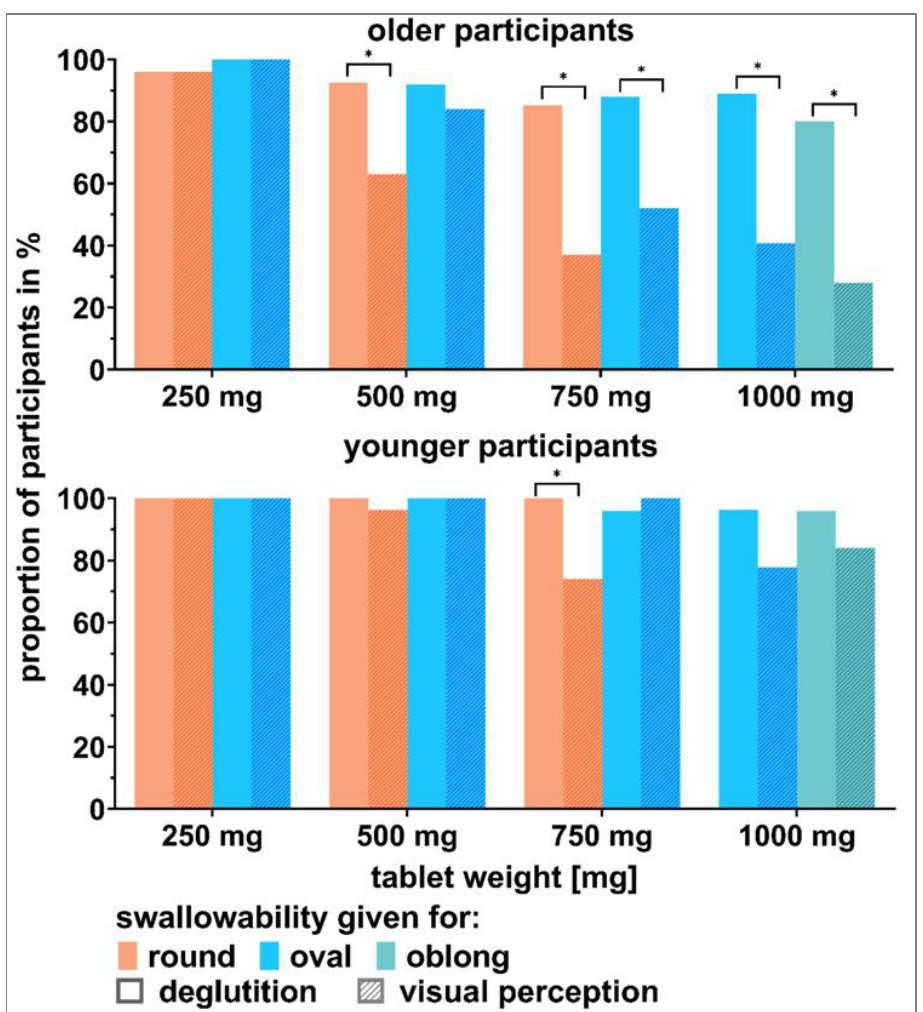
Figure 11. Comparison of the swallowability ratings after actual deglutition compared to those ac- cording to visual perception. Data of the visual perception only included ratings of those participants that had actually swallowed the particular tablets. Data are shown for older participants ( upper panel) and younger participants ( lower panel). Significant differences according to the McNemar test using paired data and consequent Benjamini–Hochberg correction ( p -value < 0.05) are marked with an asterisk.